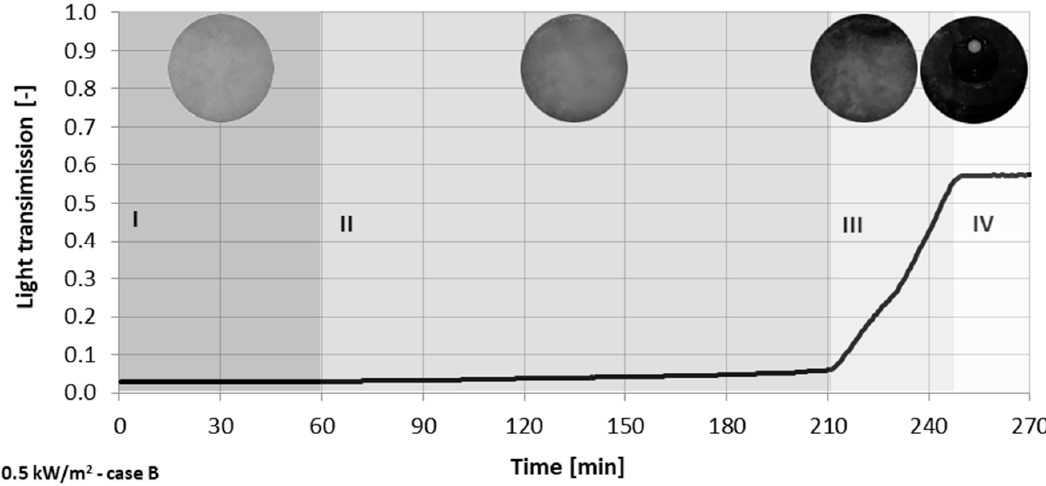
Figure 10. Direct light transmission versus time for an irradiance of 500 W/m 2 , case B.